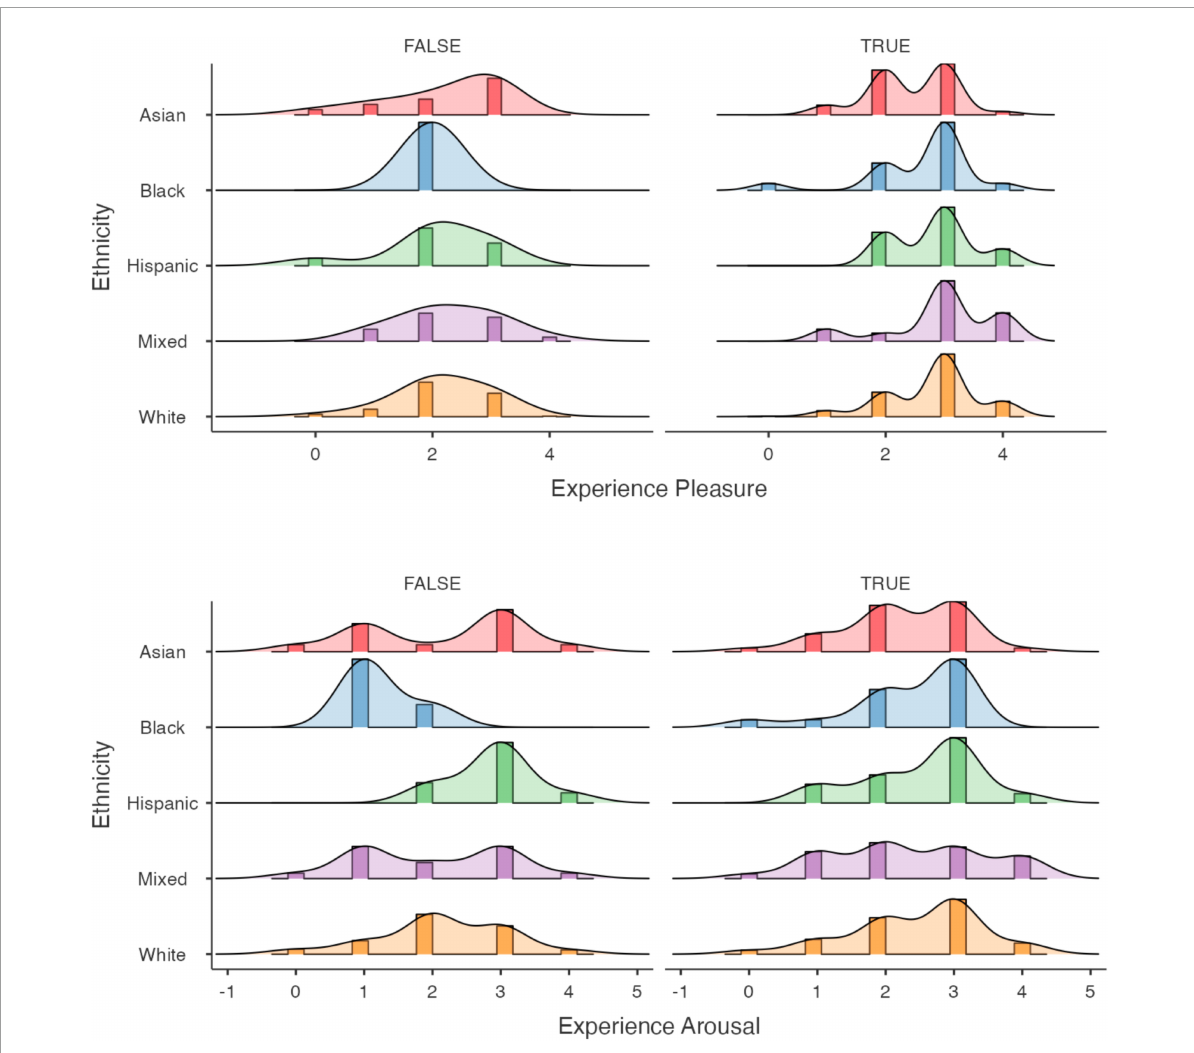
FIGURE5 Differences in experience arousal and valence ratings across ethnicities depending on whether participants experienced chills or not. It seems that participants who reported chills show greater similarity in emotional ratings of the experience as compared to those who did